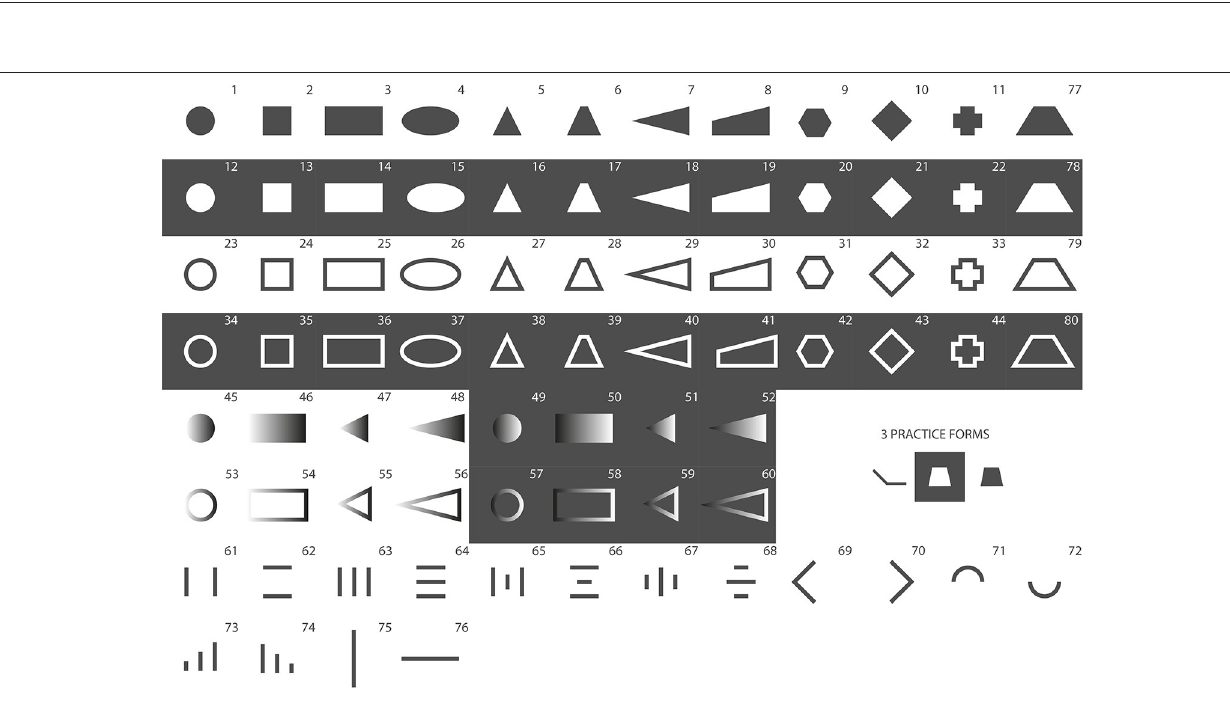
of 0.45 mm for the protruded areas (depicted in gray in